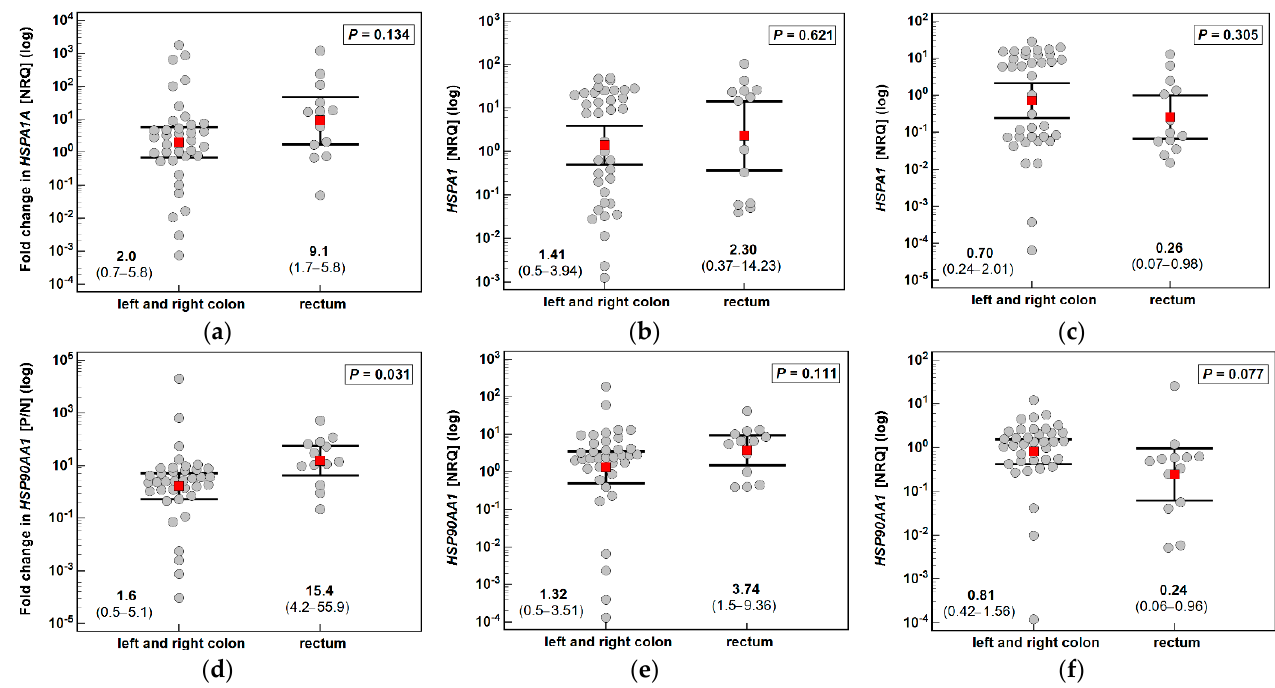
Figure 1. Association of HSP expression with polyp location: ( a ) fold change in HSPA1 expression; ( b ) HSPA1 expression in polyps; ( c ) HSPA1 expression in polyp-adjacent (normal) tissue; ( d ) fold change in HSP90AA1 expression; ( e ) HSP90AA1 expression in polyps; ( f ) HSP90AA1 expression in polyp-adjacent (normal) tissue. Data presented on logarithmic scale as geometric means (red close squares) with 95% confidence interval (whiskers) and analyzed with t -test for independent samples. P/N, polyp-to-normal ratio; NRQ, normalized relative quantity.